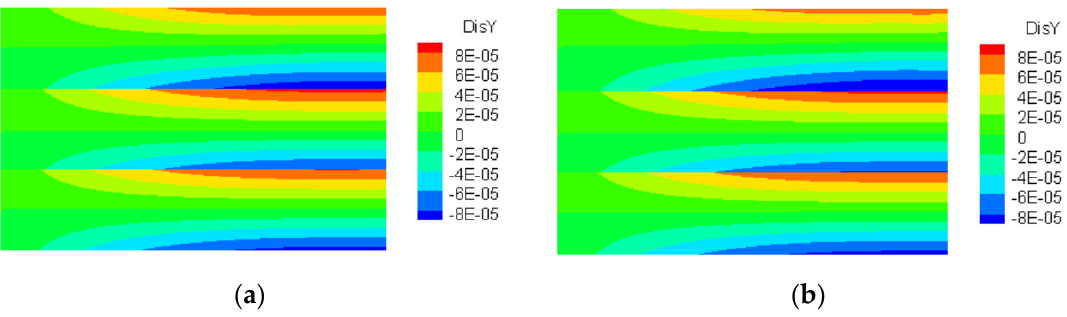
Figure 12. The distribution of displacement in Y-direction. ( a ) SBFEM. ( b ) ANSYS.